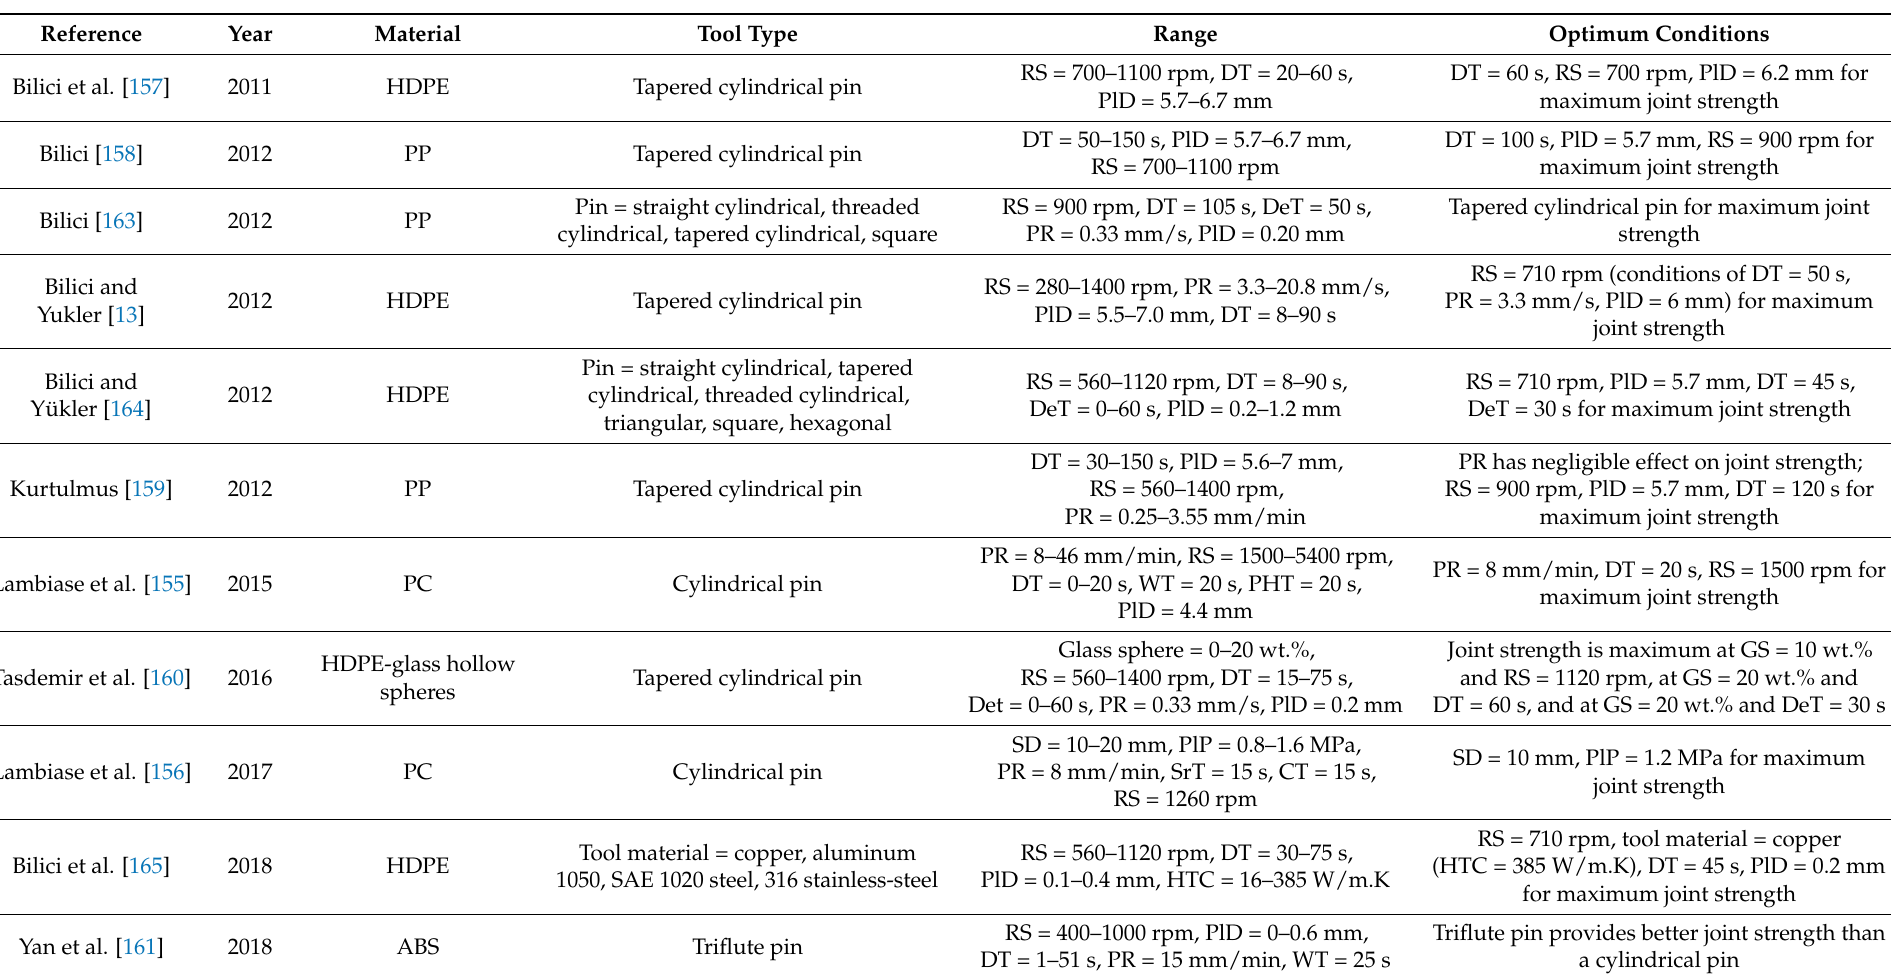
Table 7. Friction stir spot welding of thermoplastic polymer and polymer composite